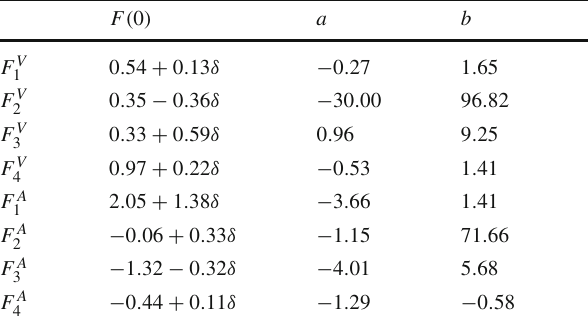
Table 1 The (cid:2) 0 c → (cid:2) − transition form factors with F ( 0 ) at q 2 = 0, where δ ≡ δ m c / m c = ± 0 . 04 from Eq.